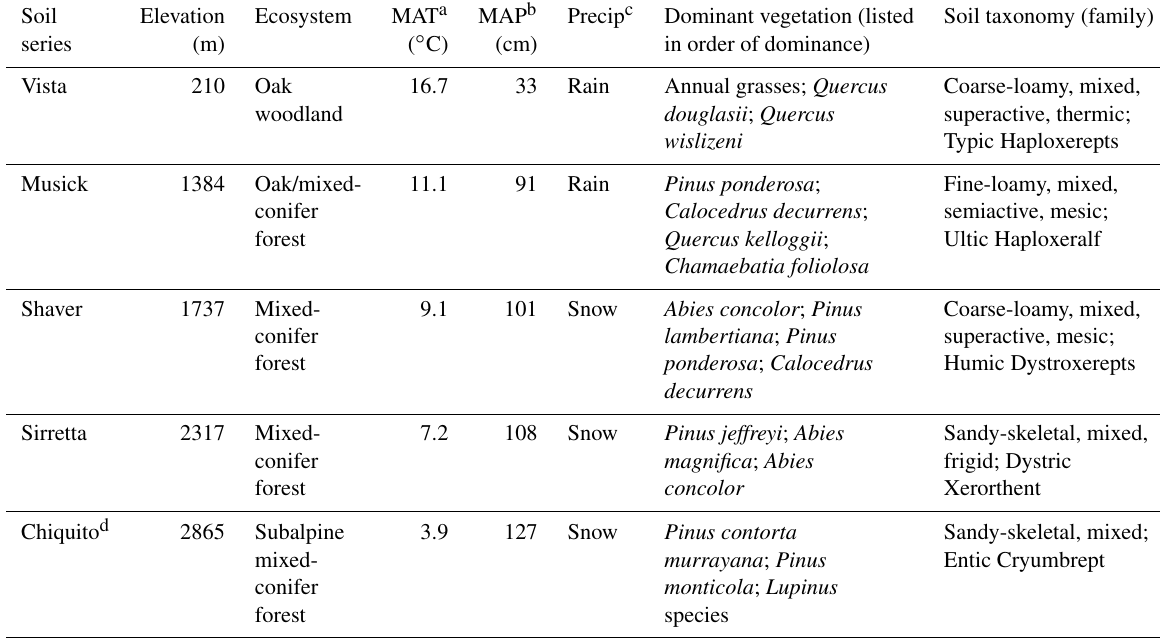
Table 1. Soil classification and site description for the five sites along elevational transect in the western slopes of the Sierra Nevada (adapted from Dahlgren et al., 1997).